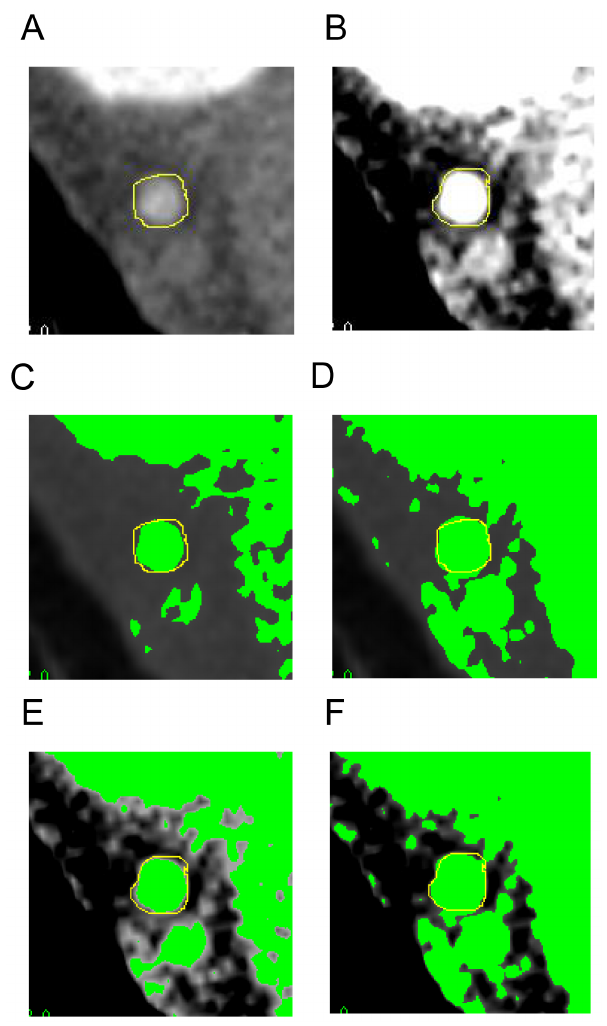
Figure 1. Independent visual determinations of the same cross- sectional image of coronary artery with different window widths/levels.